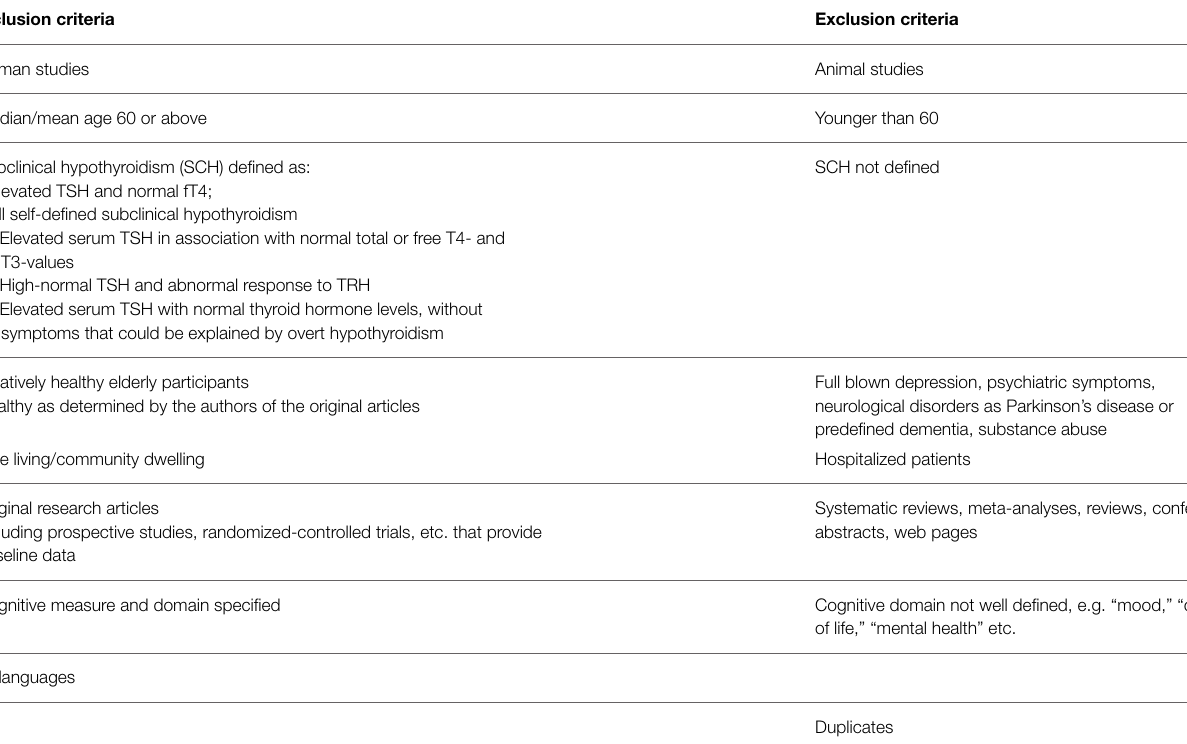
TABLE 1 | Selection criteria for eligibility for inclusion or exclusion. Inclusion